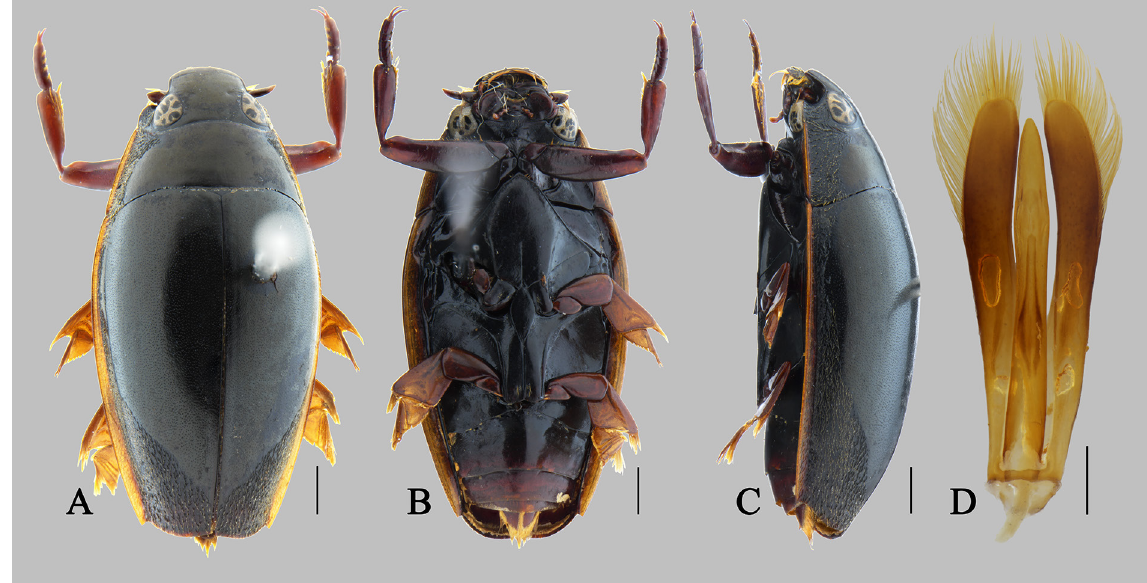
Fig. 16. Patrus procerus (Régimbart, 1884) (SYSU). A . ♀, habitus, dorsal view. B . ♀, habitus, ventral view. C . ♀, habitus, lateral view. D . ♂, genitalia. Scale bars: A–C = 1 mm; D = 0.5